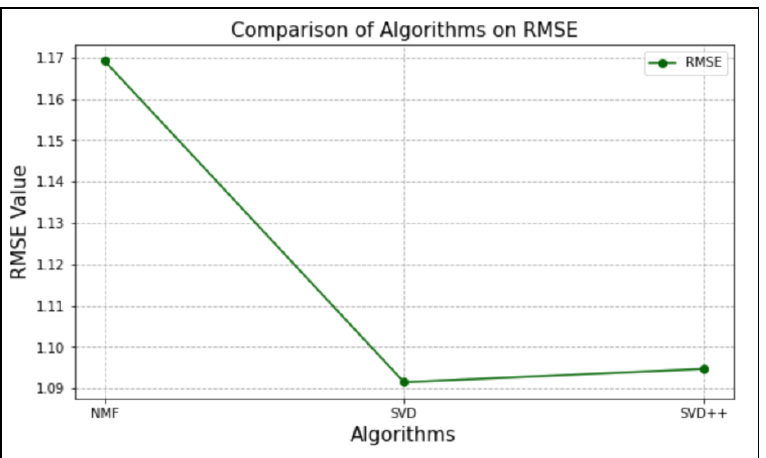
Figure 2. Method comparison based on the RMSE metric.